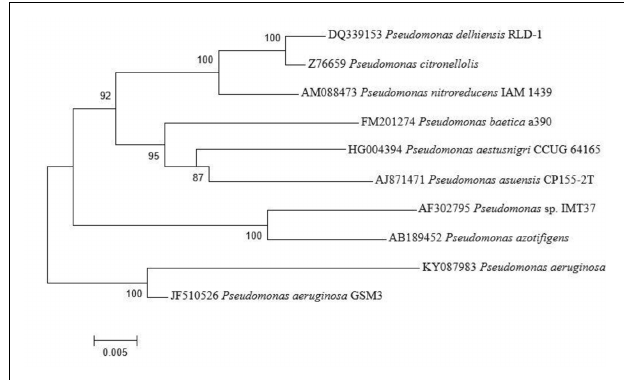
FIGURE 1 | Phylogenetic analysis of 16S rRNA sequences of the bacterial isolate AL2-14B isolated from A. aspera L. The analysis was conducted with MEGA6 using neighbor-joining